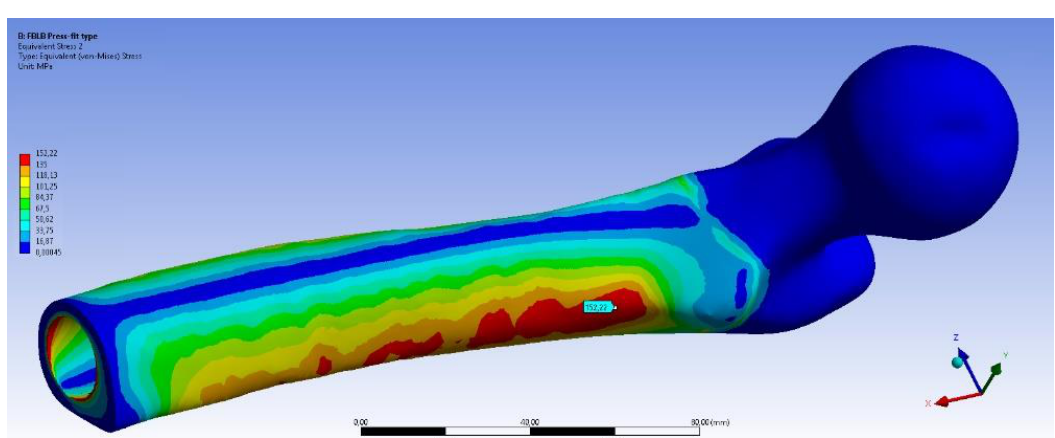
Figure 11. Fall Backwards with Balance Loss (FB BL) scenario: von Mises stress distribution on femur using the OPRA ( top ) and the OPL ( bottom ) device.